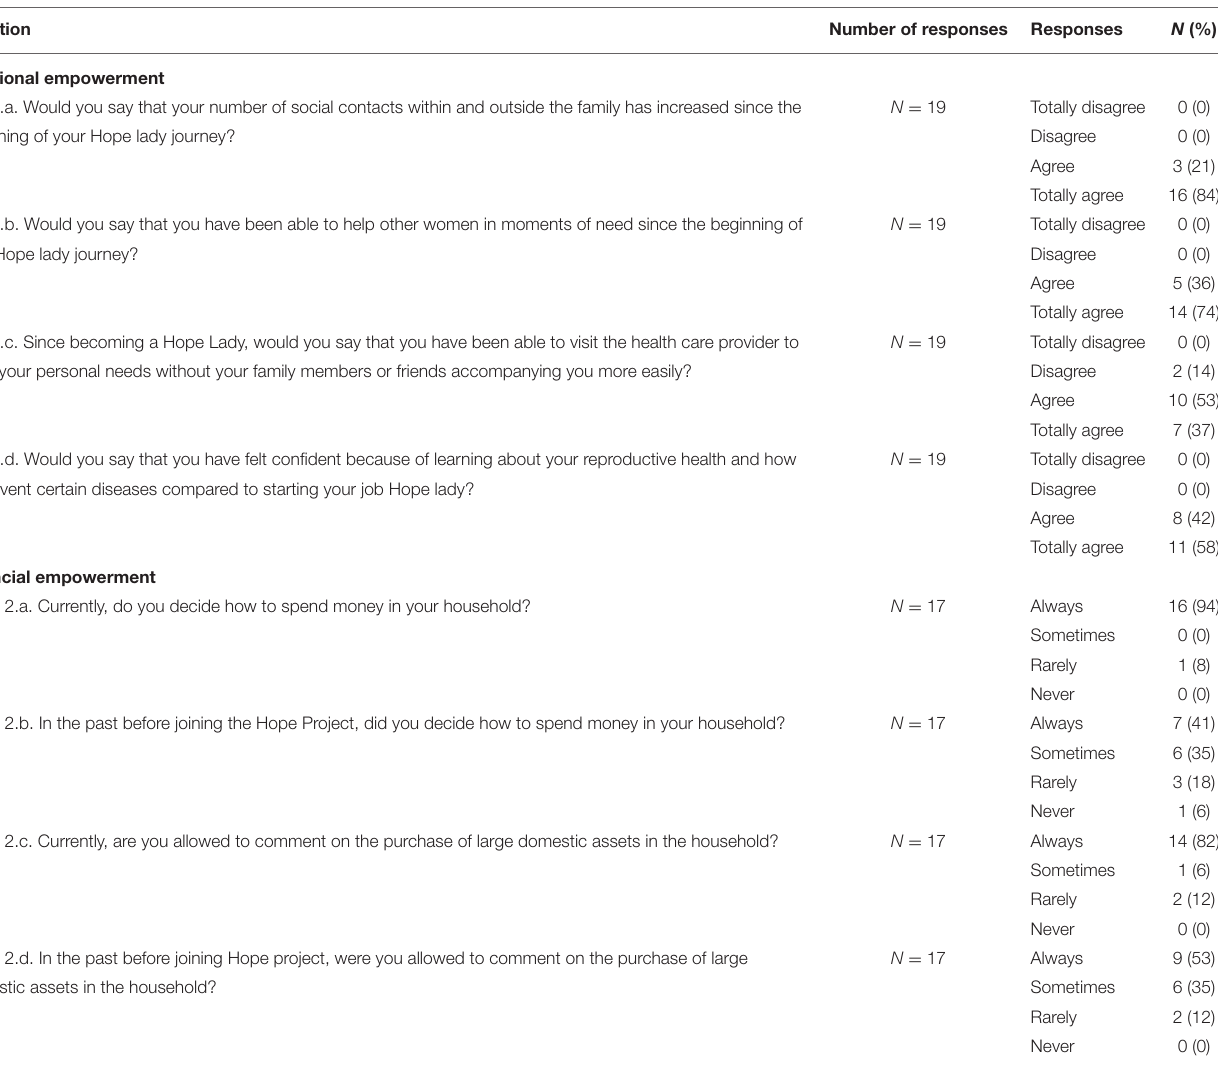
TABLE 2 | Relational and financial empowerment survey